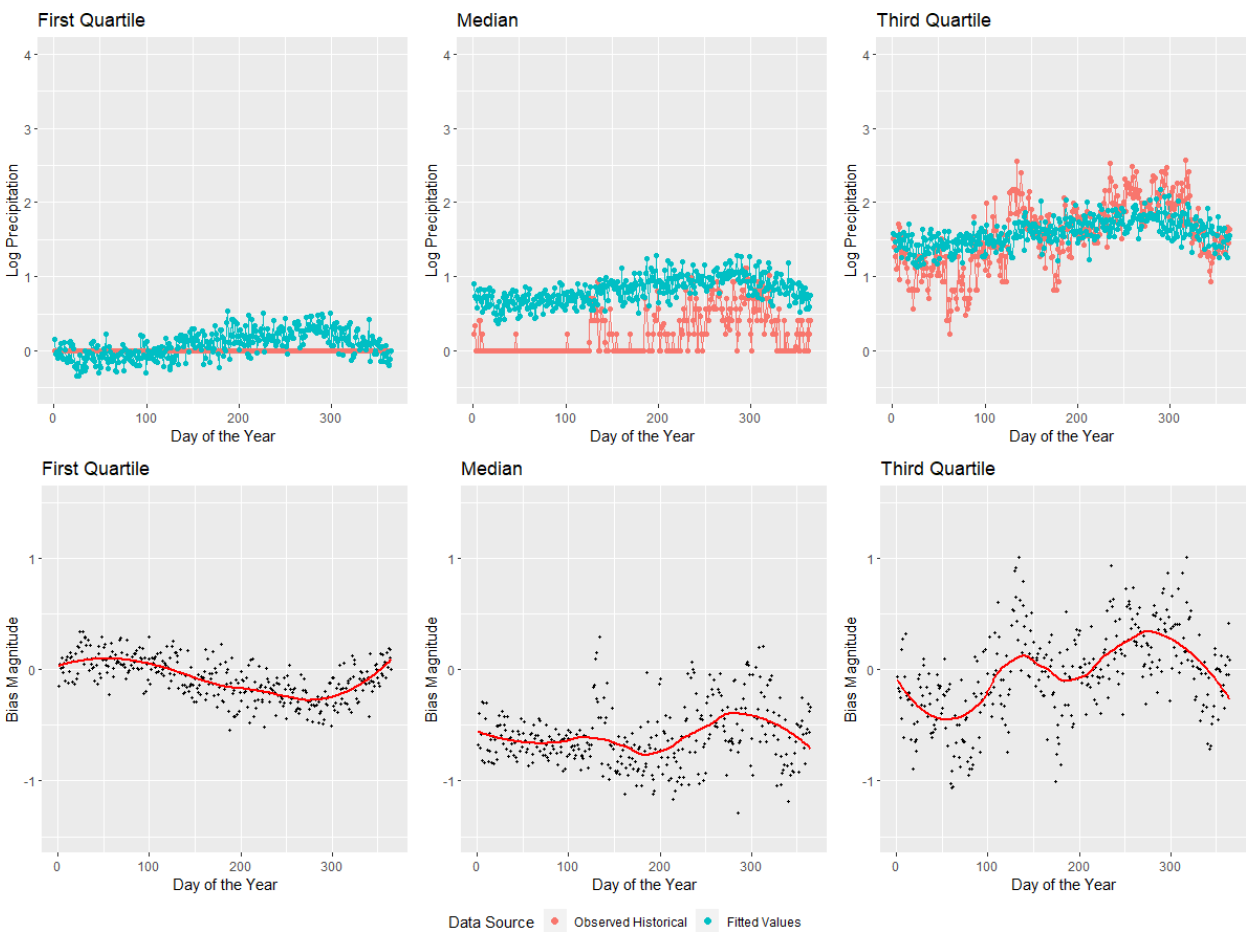
Figure 6. Quartiles of fitted (cyan) and observed (red) log precipitation (mm) as a function of Julian day (top panel) using Canada’s CanESM2. The differences between the observed and fitted precipitation along with a LOESS smoothing spline with smoothing parameter λ = 0 . 50 (bottom panel). This figure was created using Wickham